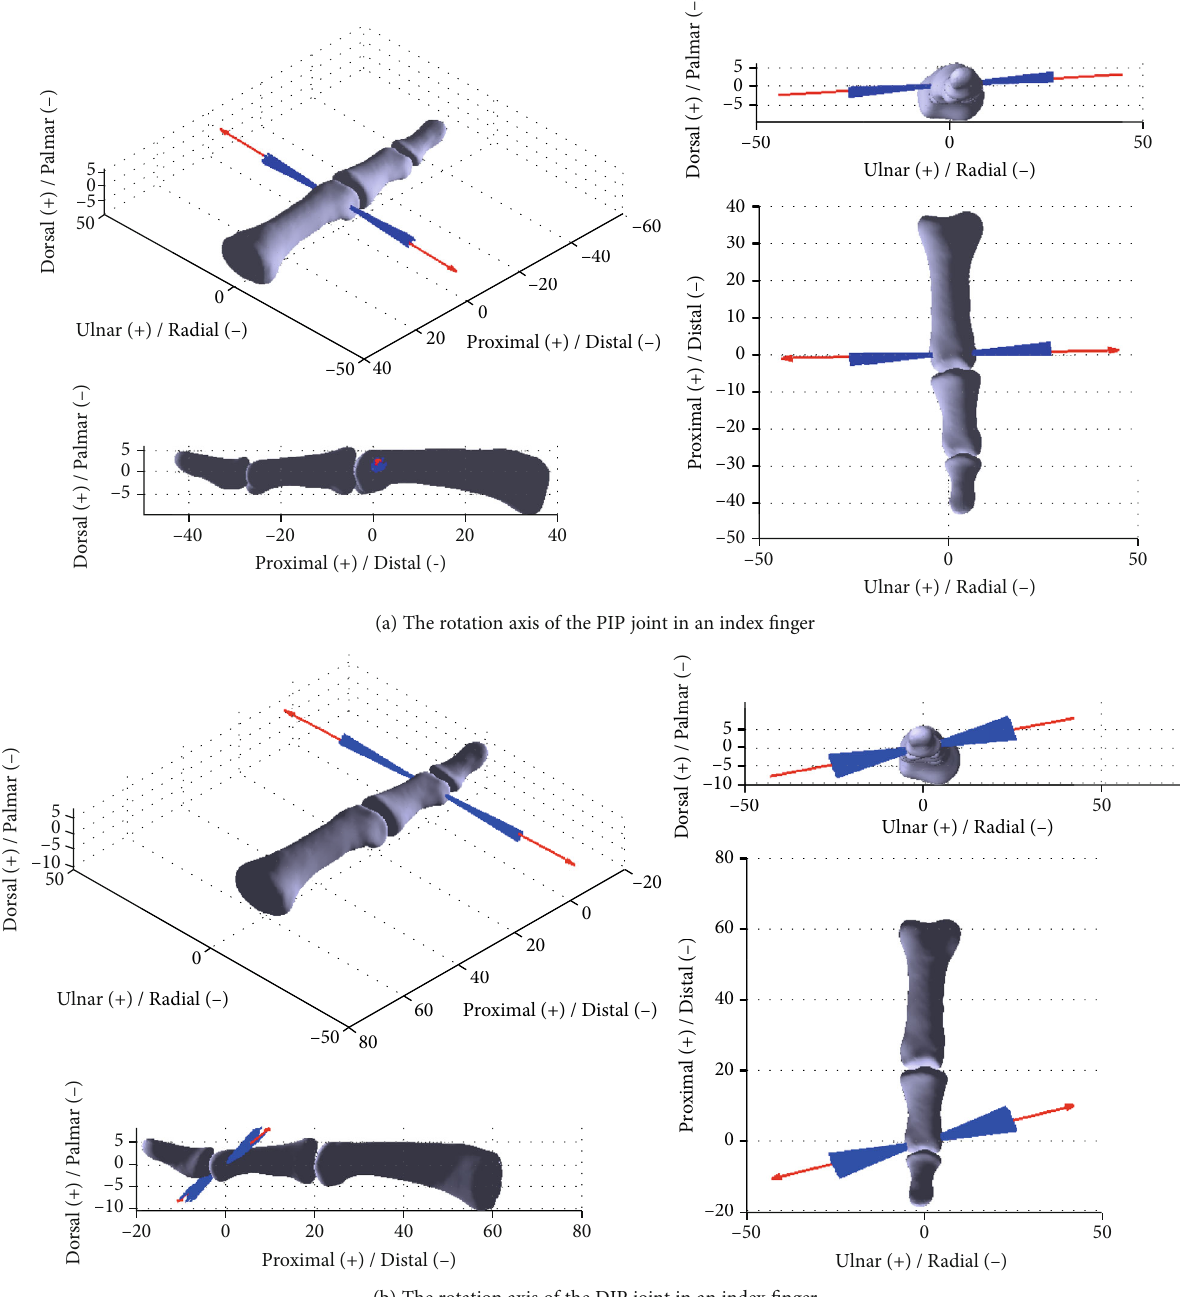
Figure 5: The rotation axes in PIP and DIP joints in an index fi